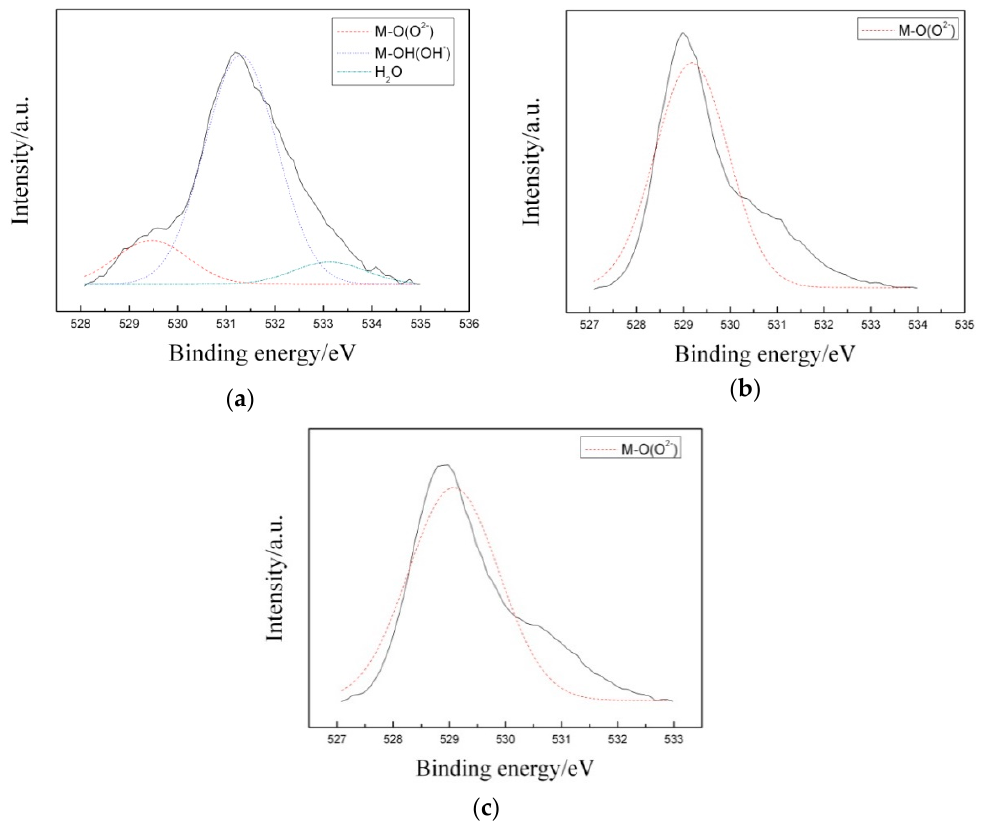
Figure 9. Narrow XPS of O1s with different sputtering depths ( a ) 0 nm; ( b ) 1 nm; ( c ) 2 nm.